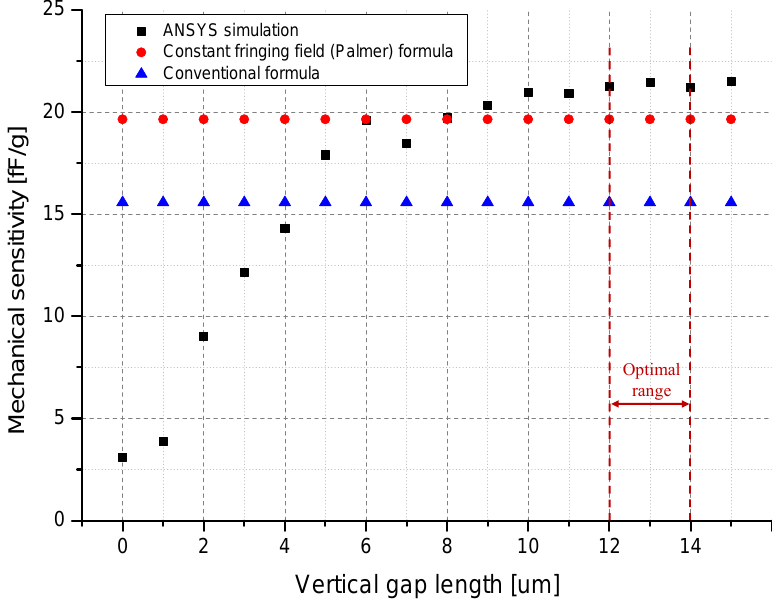
Figure 7. Simulation result of mechanical sensitivity vs. vertical gap